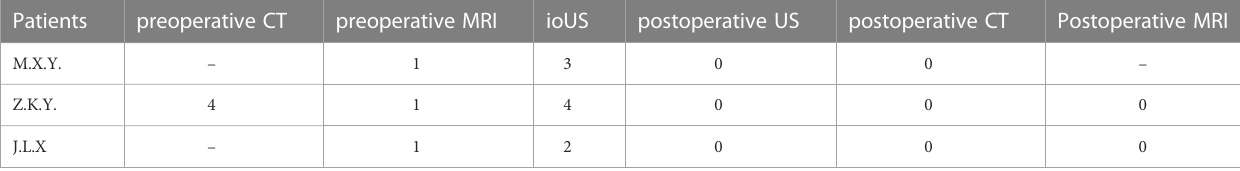
TABLE 4 Number of tumors in representing patients on preoperative CT, MRI, ioUS, postoperative US, postoperative CT and MRI.